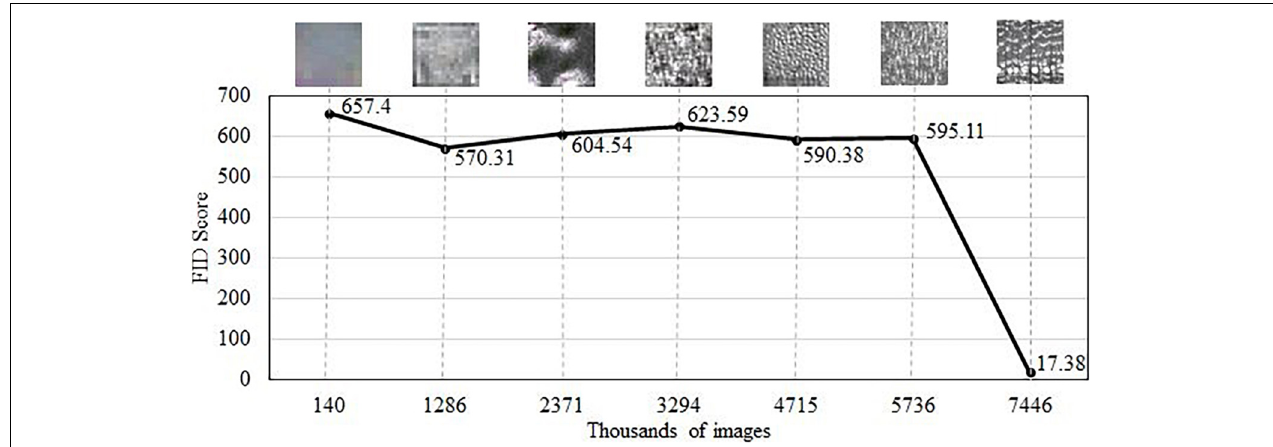
FIGURE 5 | The Fréchet inception distance (FID) score achieved by the StyleGAN generative adversarial network (GAN) on cross-section images of hardwood species. Top images show the evolution of anatomical detail with